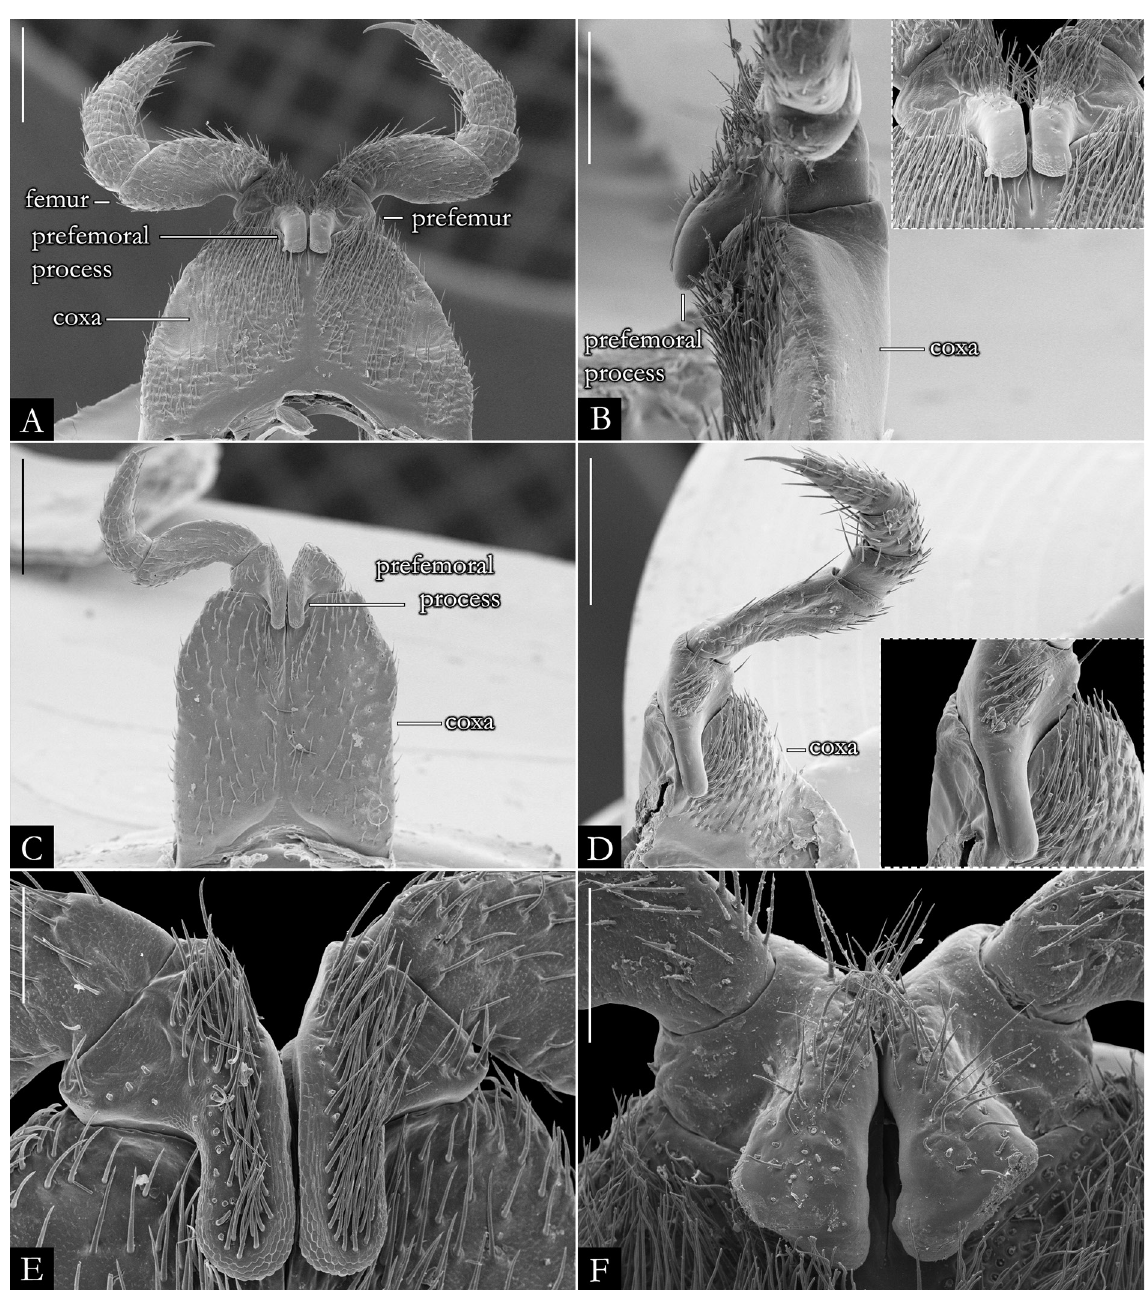
Fig. 30. SEM images of first leg-pair of males. A . Pseudonannolene caatinga Iniesta & Ferreira, 2014 (IBSP 2180). B . P. microzoporus Mauriès, 1987 (IBSP 3526), detail of prefemoral process of P. caatinga (IBSP 2180). C . P. halophila (IBSP 1091). D . P. rolamossa Iniesta & Ferreira, 2013 (IBSP 7772). E . P. maritima Schubart, 1949 (IBSP 979). F . P. erikae Iniesta & Ferreira, 2014 (IBSP 7607). Scale bars: A, C–D = 0.5 mm; B = 0.3 mm; E = 0.2 mm; F = 0.3